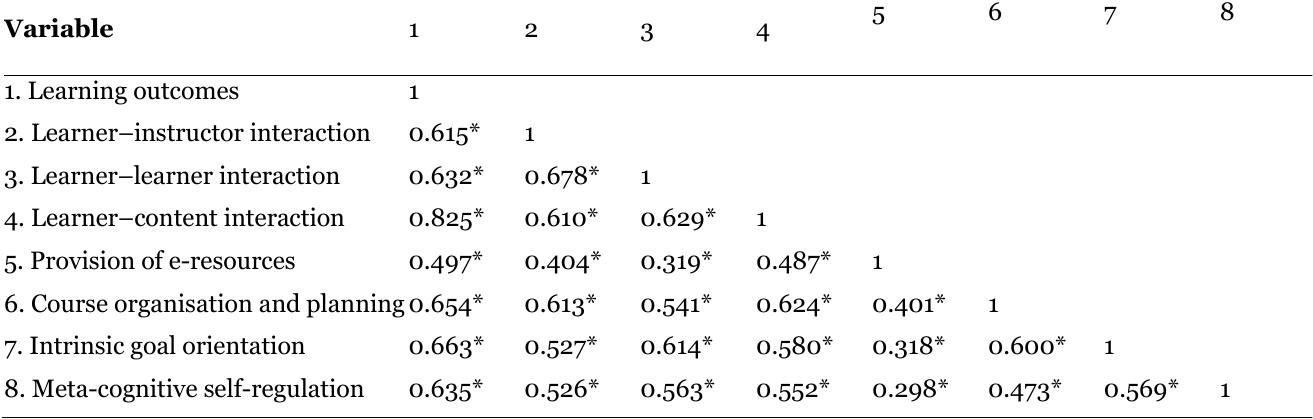
Correlations Among the Outcome Variable and Continuous Predictors Variable